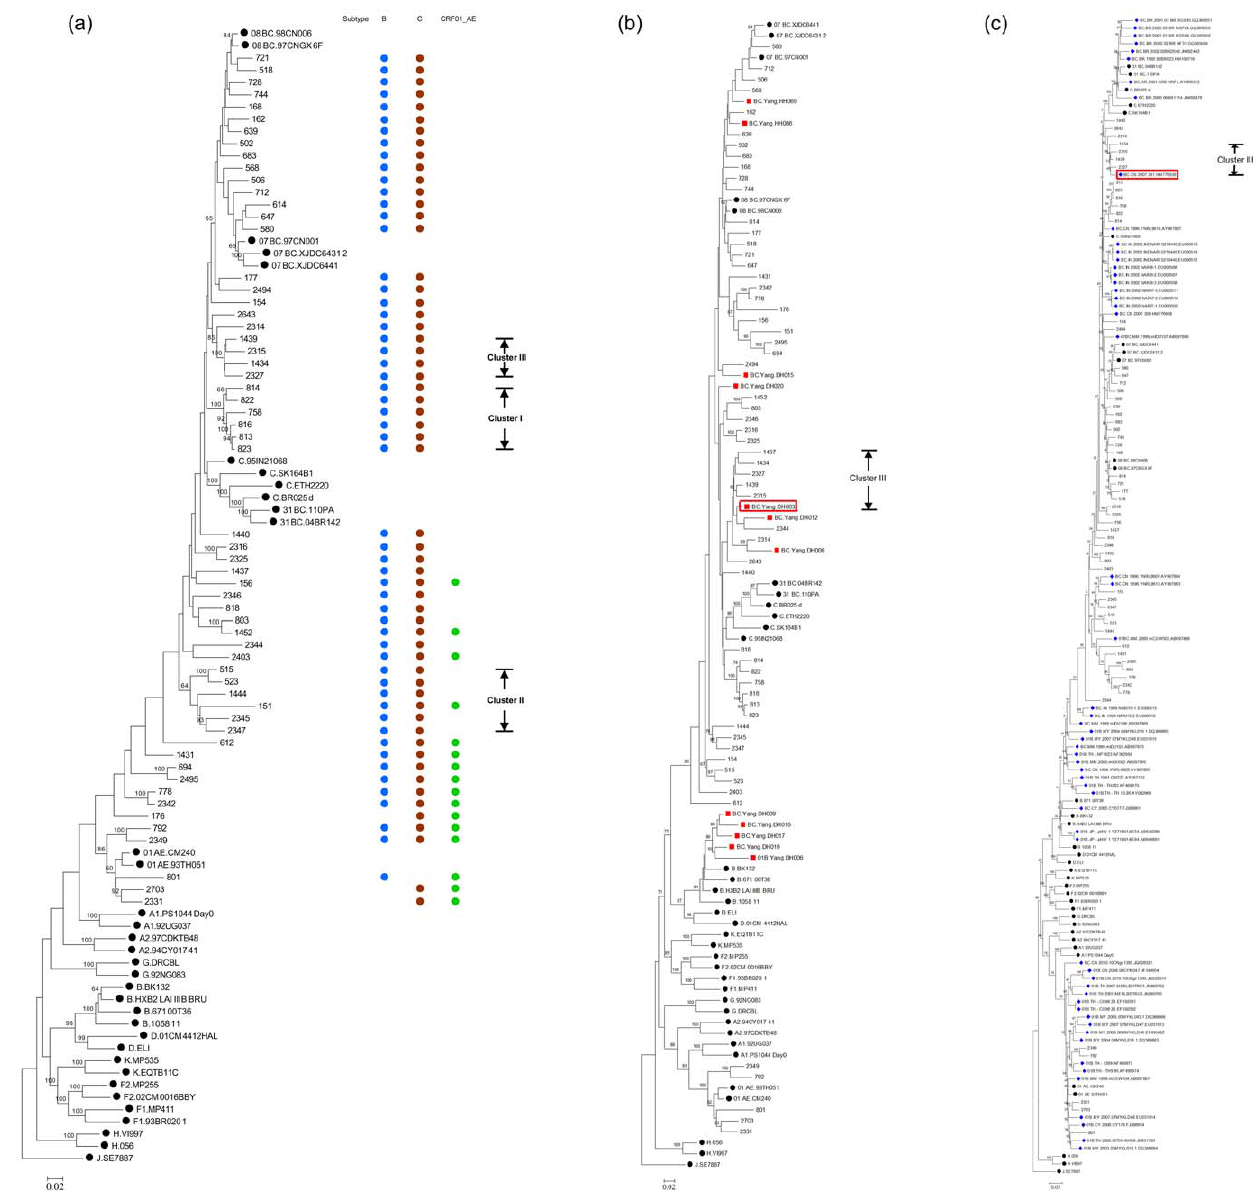
Figure 1. Phylogenetic tree analysis. (a) Full length gag and pol genes from same isolates were assembled together. Maximum Likelihood trees created with the 59 full length gag - pol gene of HIV-1 URFs sequences from Yunnan and a selection of reference sequences of subtype A–D, F–H, J, K, CRF01_AE, CRF07_BC, CRF08_BC and CRF31_BC (black dots, http://hiv-web.lanl.gov/- see Materials and Methods for details of selection of reference sequences). The length of sequences used in the analysis was 4307 base pairs respectively by using HXB2 as the reference genomic. Each reference sequence is labeled with the HIV-1 subtype, followed by name. Branch support values greater than 60% are indicated at the corresponding nodes of the tree. The scale bar represents 2% genetic distance. The compositions of genomes were indicated in right column. Three clusters containing more than 3 strains with high branch support values were labeled accordingly. (b) Full length gag and partial pol genes (2.6 Kb) of 12 strains from Yang’s paper were aligned together with 59 strains identified in this study and subtype references sequences. ML tree was constructed as described in the methods. Strains from Yang’s paper were labeled with the HIV-1 subtype, followed by ‘‘Yang’’ and strain’s name. Branch support values greater than 60% are indicated at the corresponding nodes of the tree. All strains from Yang’s paper were labeled with red square ( & ). Strain located in red rectangle was the one (DH003) presenting same genomic structure as strains in Cluster III. (c) Full length gag - pol genes downloaded from HIV Los Alomas database of URFs in Asia containing B, C or CRF01_AE segments were aligned with strains identified in this study. ML tree was constructed as described in the methods. Strains downloaded from database were labeled with the HIV-1 subtype, followed by country, year, name and accession number. Branch support values greater than 60% are indicated at the corresponding nodes of the tree. All strains from database were labeled with blue diamond ( ¤ ). Strain located in red rectangle was the one (341) presenting same genomic structure as strains in Cluster III. doi:10.1371/journal.pone.0046777.g001 different genomic regions were adopted in determining viral recombinant forms of URFs were also in changing. In previous subtypes, it is kind of hard to compare both results, but our data studies, URFs containing genomes composed of subtype B 9 and C supposed the possible change of URFs prevalence in Yunnan. The were dominant [22,23]. In this study, although recombinant